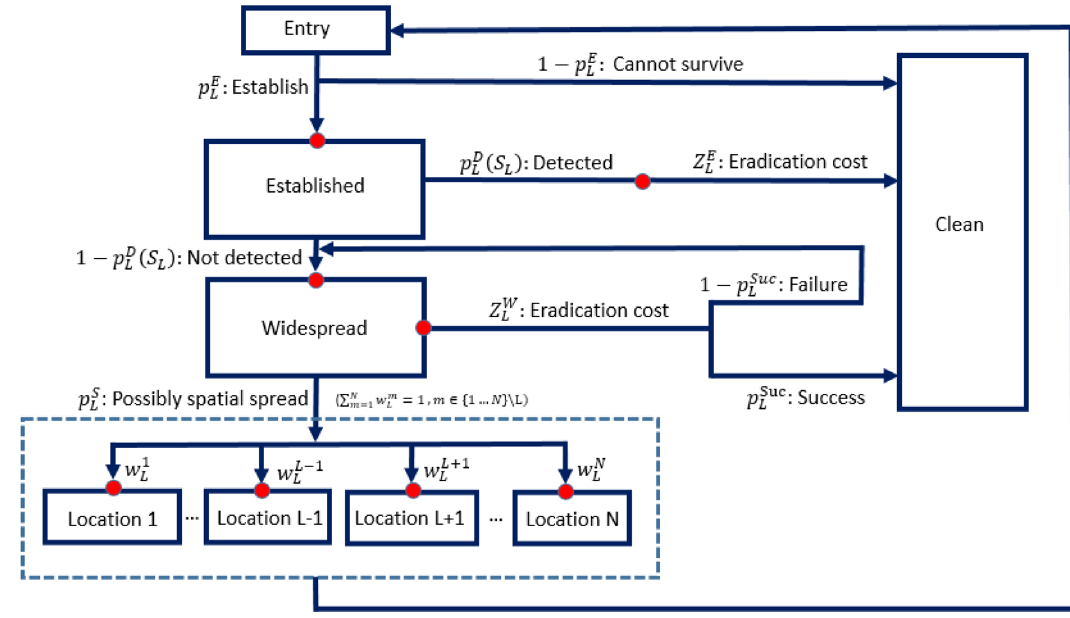
Figure 2. Post-border spatial dispersal modelling 10 . After an individual invasive species enters location L , the probability of its survival and establishment at location L is p E L . The cost of non-survival is zero. The probability of it being detected after establishment with surveillance cost S L spent at location L is p D L ( S L ) . Once detected, it will be eradicated with eradication cost Z E L ; if not, it will become widespread at location L , or even move to other potential locations m = 1, 2, . . . , n \ L with probability p S L w m L ( p S L is a common coefficient that is specific to location L , w m L is a spatial connection weight between location L and m ) and another loop process starts. It is assumed that when the invasive species becomes widespread at location L , the invasive species could be detected with 100% probability. The following eradication conducted with budget Z W L (much higher than Z E L ), may fail N = 1, m ∈ { 1, 2, . . . , n }\ L w m with probability 1 − p Suc L . It should be noticed that L m = 1 (cid:31) The system model results applied to calculate the eradication cost r is then evaluated against a certain thresh- old value r α , requiring the eradication cost no more than r α ( r ≤ r α ) . r α can be interpreted as a maximum budget,